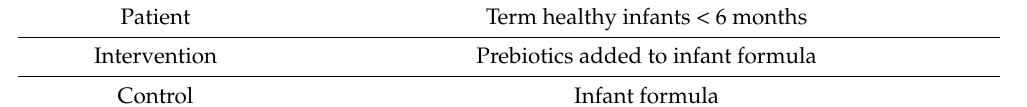
Table 1. Research question and PICO (population, intervention, control, and outcomes) formulation. Is there a link between the type of prebiotic added to infant formula and the reduction in the incidence of infection in infants? Patient Term healthy infants < 6 months Intervention Prebiotics added to infant formula Control Infant formula Primary outcome: Reduction in the incidence of infections Secondary outcomes: Reduction in the prescription of antibiotics and Outcome their links with the type of prebiotic. Effects on subtypes of infection (e.g., upper airway, lower airway, intestinal infection,